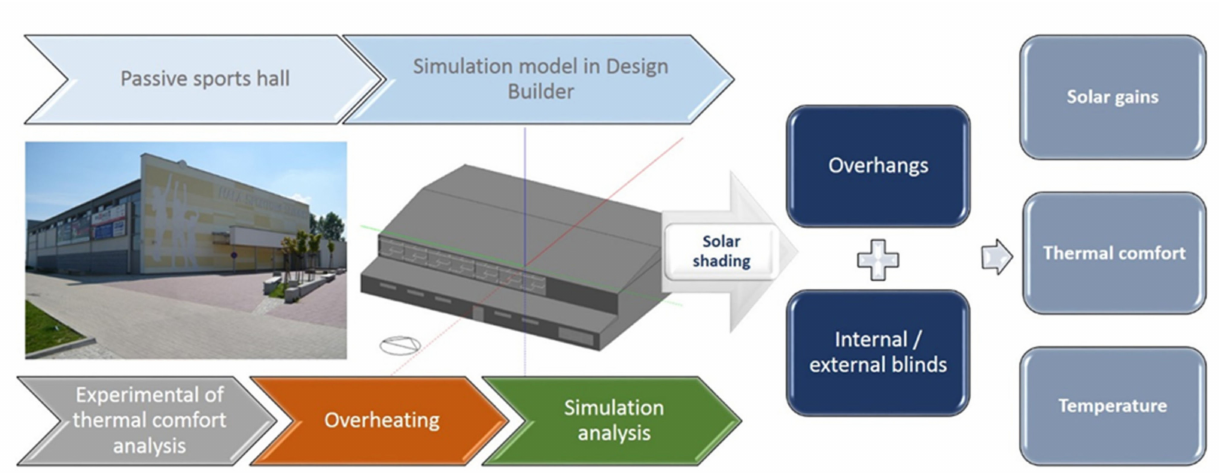
Figure 6. Indoor air temperature distribution during the summer measurement and the values obtained from the simulation model for the studied sports arena.